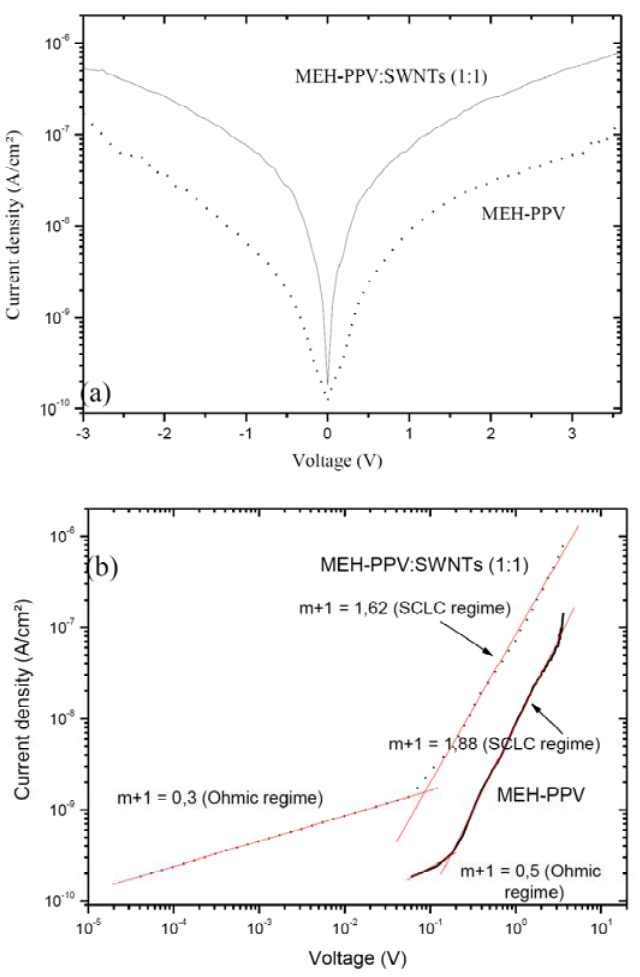
Figure 1. (a) Dark J-V characteristics of ITO/MEH-PPV/Al and ITO/MEH-PPV:SWNTs (1:1)/Al devices plotted on a semi-logarithmic scale, (b) same characteristics in logarithmic